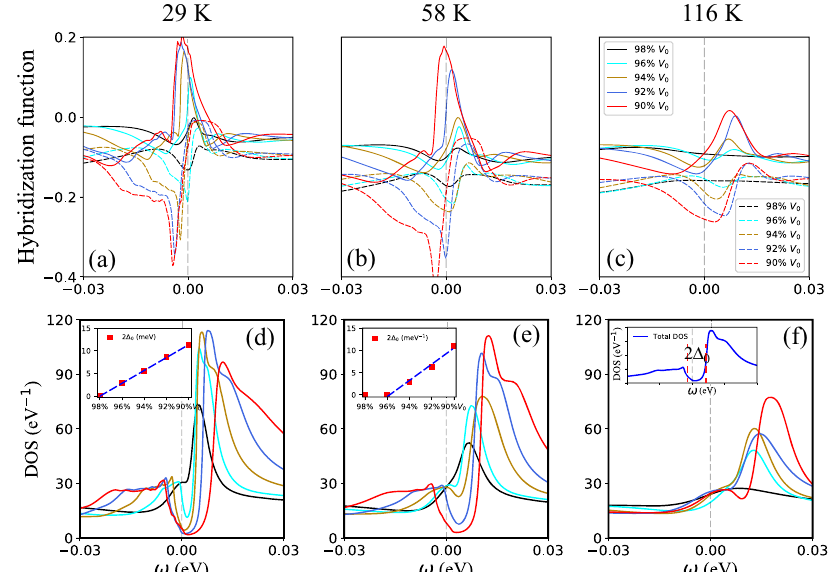
Fig. 2 Pressure dependence of hybridization function and local spectra density. a – c The real (solid lines) and imaginary (dashed lines) part of the hybridization function. d – f the integrated spectra density at 29, 58, and 116 K, for 98%, 96%, 94%, 92%, and 90% compressed cell volume, respectively. The magnitude of the energy gap is plotted as the function of cell volume shown in the inset of ( d , e ). The gap size is evaluated from the half-height of the maximal intensity at the gap edge below E F to the minimal intensity value inside the gap as schematically illustrated in the inset of ( f ). The black dashed line in the inset of ( f ) marks the valence bands edge E v .